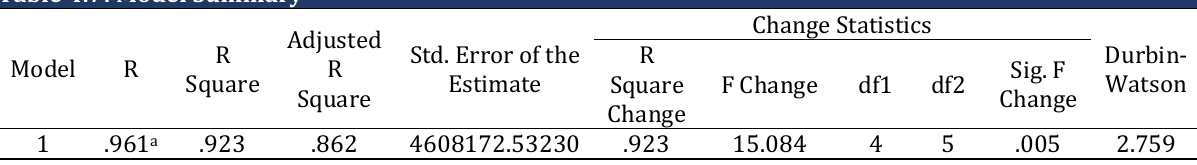
Table 4.7: Model Summary b